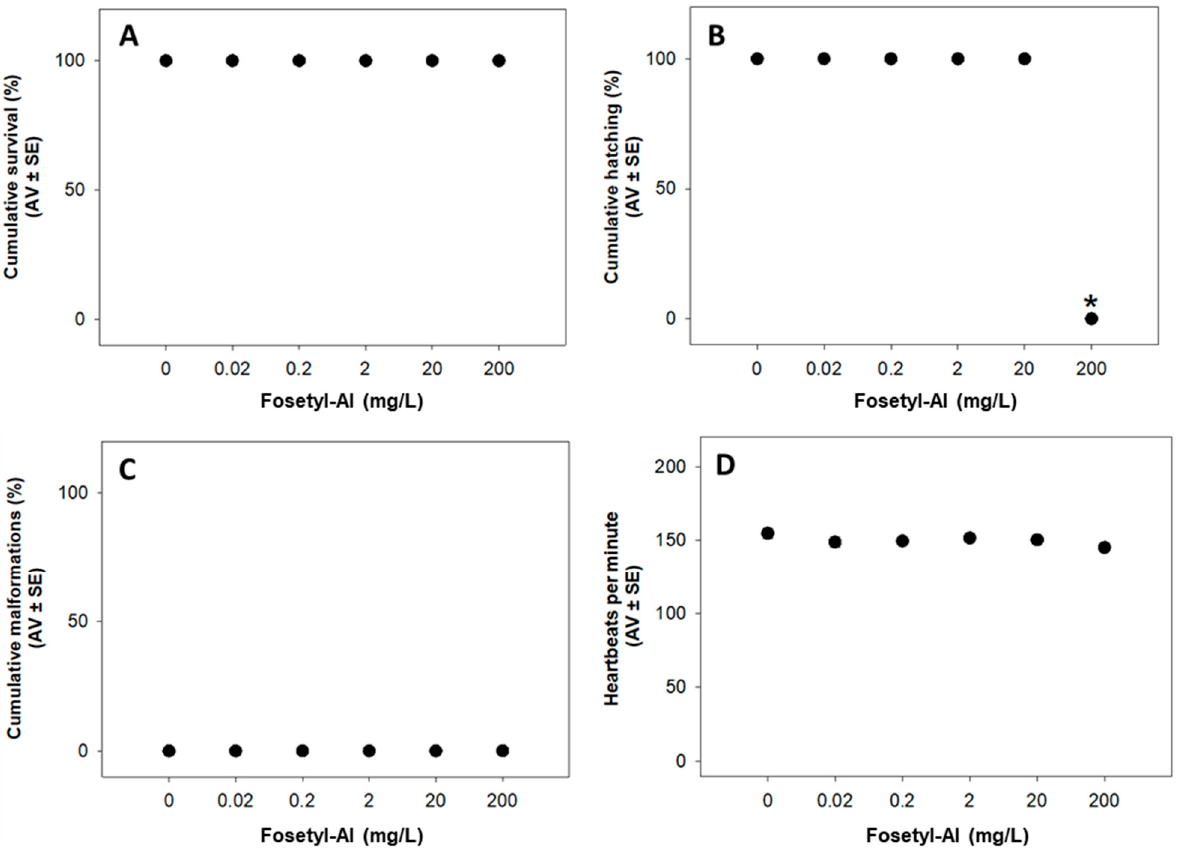
Figure 1. Effects of 96 h of exposure to fosetyl-Al on zebrafish embryos for survival ( A ); hatching ( B ); appearance of malformations ( C ); and heartbeat at 48 h ( D ). Data are expressed as average value (AV) ± standard error (SE). * Significant differences to control ( p <